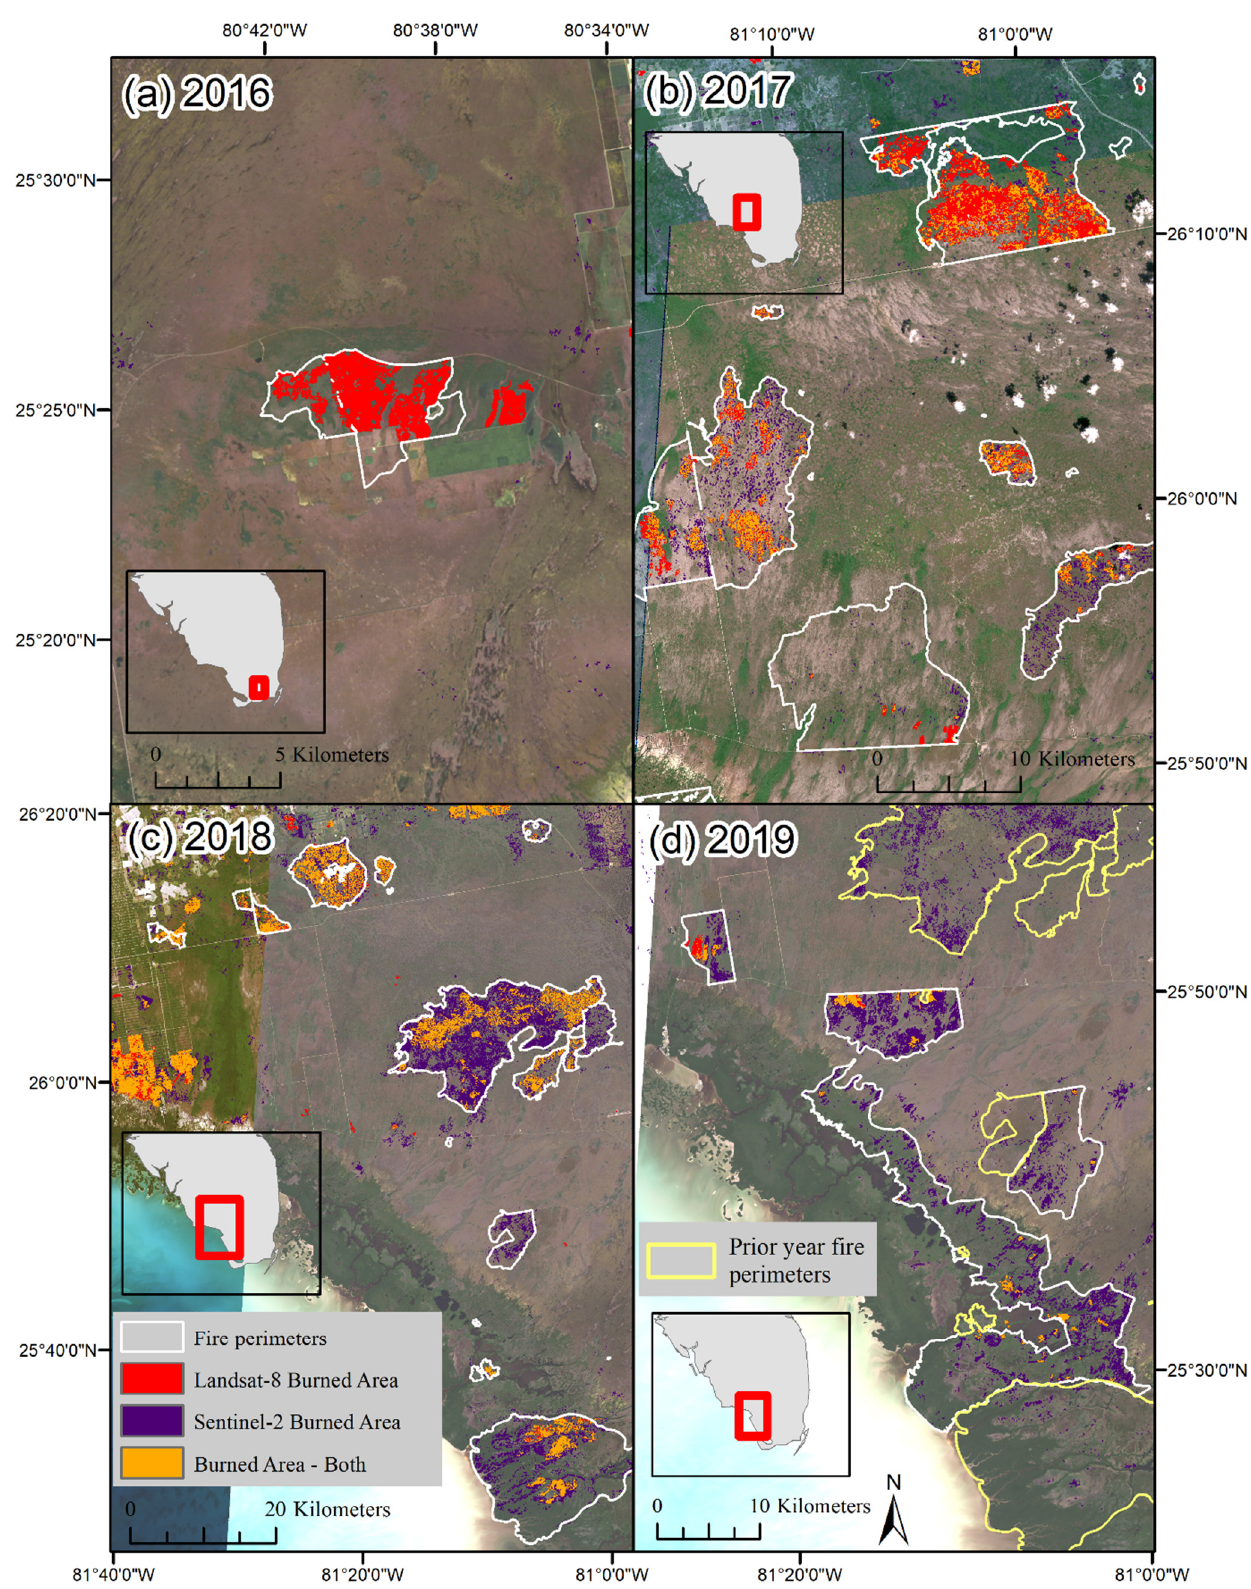
Figure 4. Examples from the Florida Everglades showing the contribution of burned area extent from Sentinel-2 in ( a ) 2016 and ( b ) 2017 with Sentinel-2A only, relative to ( c ) 2018 and ( d ) 2019 with both Sentinel-2A and Sentinel-2B. Background images include Landsat-8 images from 24 January 2016 and 22 March 2017, and Sentinel-2 image from 17 March 2017.